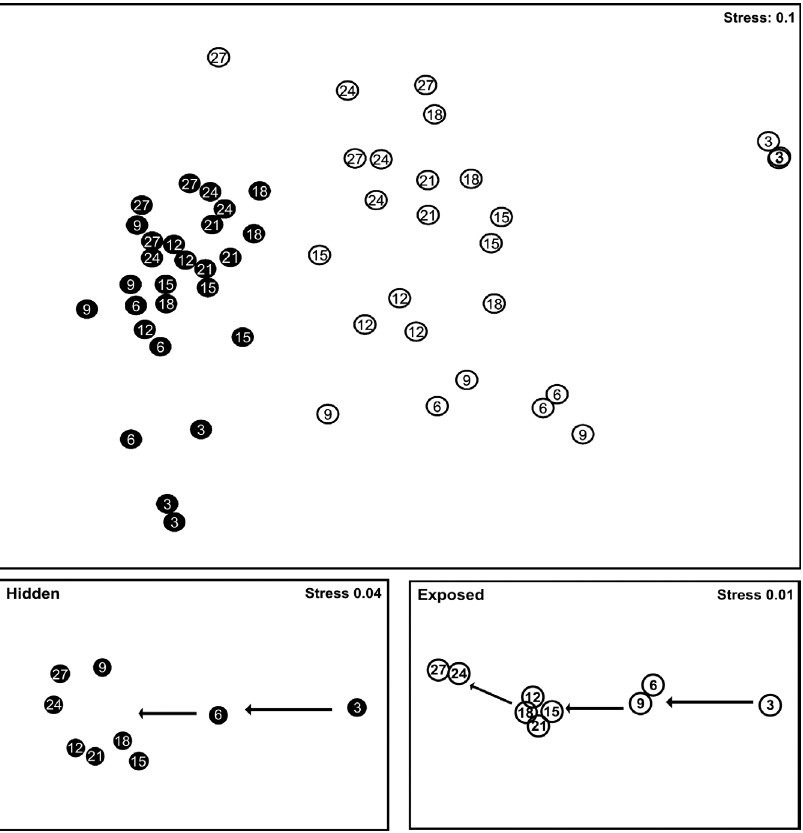
Fig . 3. – Non-metric MDS plot (upper) derived from Bray-Curtis measures with square-root-transformed data of communities developed on exposed surfaces (open circle) and hidden surfaces (filled circle). Non-metric MDS plots derived from Euclidian distance calculated from the R-values resulting from pairwise comparisons after ANOSIM from communities developed on exposed surfaces and hidden surfaces. Numbers indicate the months after the panel’s